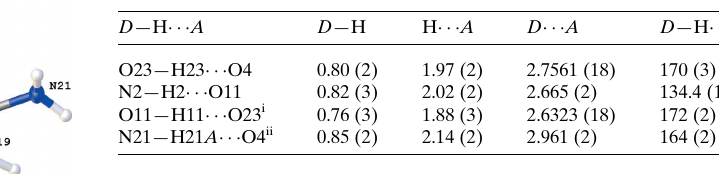
Table 1 Hydrogen-bond geometry (A˚ , (cid:3) ).